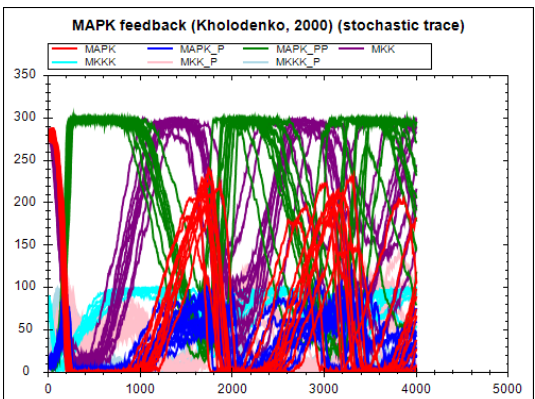
Figure A.7: The simulation result from the simulation description given in List- ing A.5. Simulation with SED-ML web tools [2].